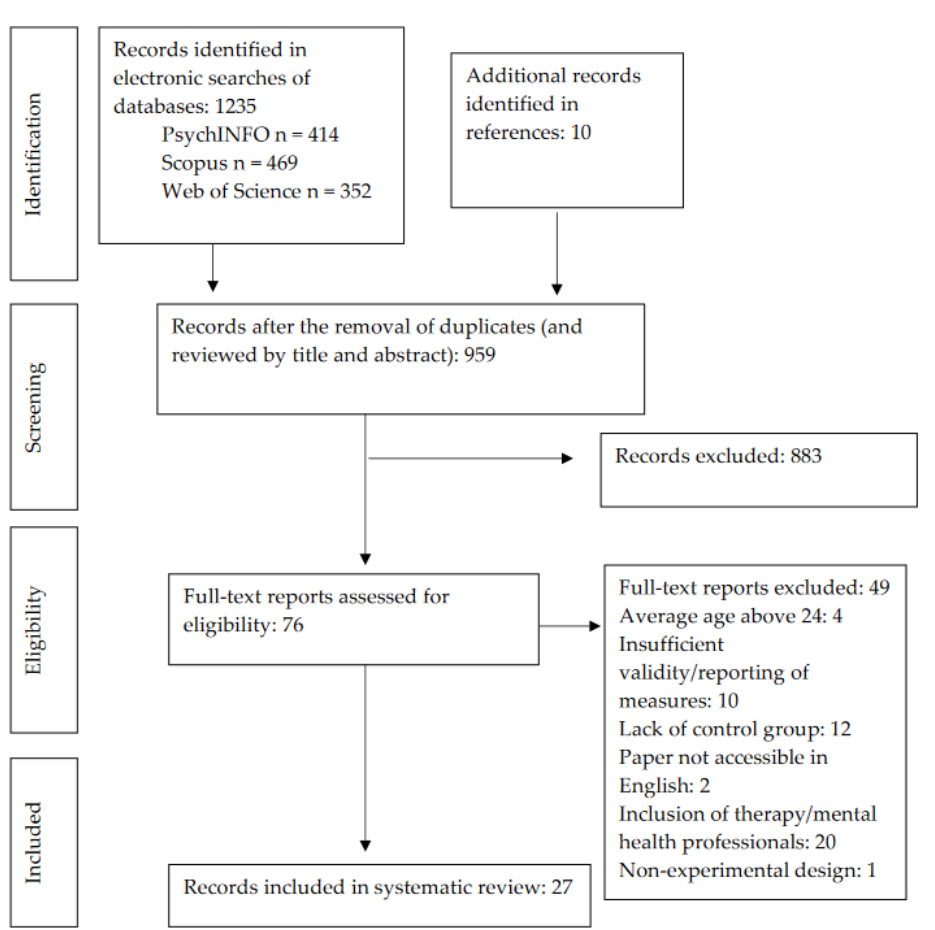
Figure 1. Study Selection Process Based on PRISMA Guidelines.